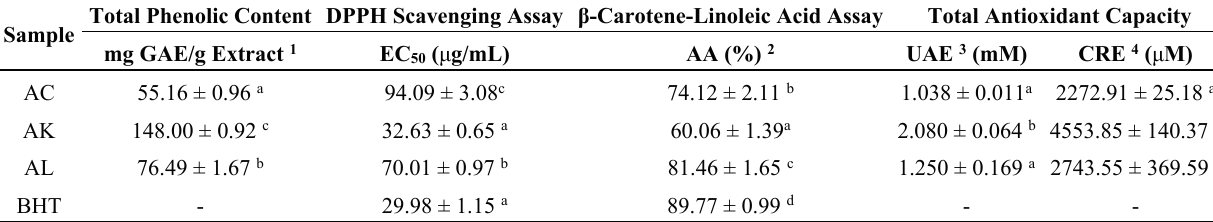
Table 2. Total phenolic content and antioxidant activity of Achillea extracts